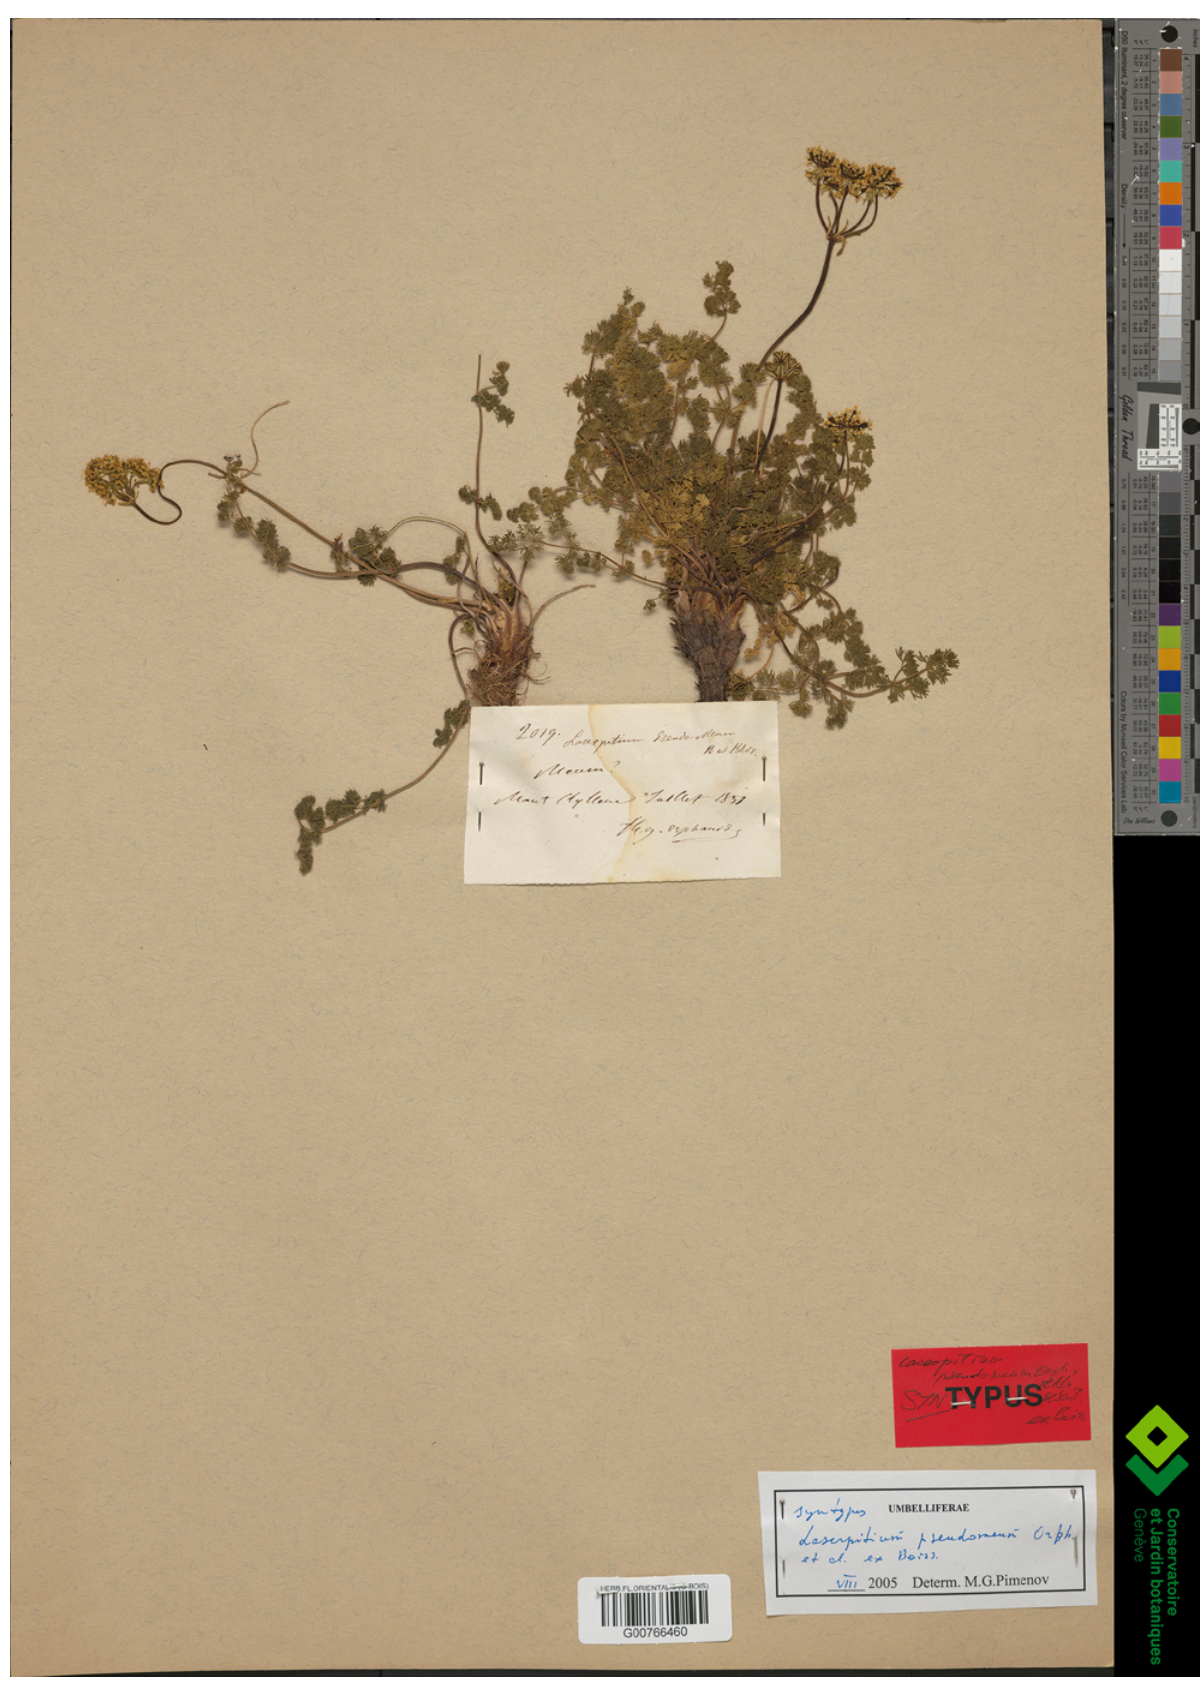
Fig. 2 Lectotype of Laserpitium pseudomeum Orph., Heldr. & Sartori ex Boiss., designated here. Photograph © Conservatoire et Jardin botaniques de la Ville de Genève, reproduced with